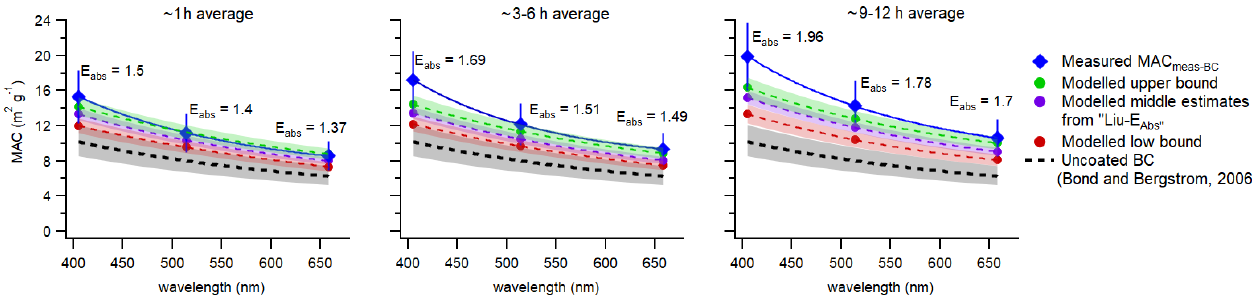
Figure 7. The measured and modelled MAC values at 405, 514 and 658nm in sampled smoke with different ages, including the measured MAC meas-BC (blue markers), the low (red circle markers) and upper (green circle markers) limits, and approximately middle estimates (purple circle markers, from Liu- E Abs ) of modelled MAC (MAC modelled ). The uncertainties of MAC meas-BC include the instrument uncertainties and the fit errors. The uncertainties of MAC modelled are from the Monte Carlo analysis as in Taylor et al. (2020). The black dashed lines and shaded areas represent the MAC and uncertainties of uncoated BC reported by Bond and Bergstrom